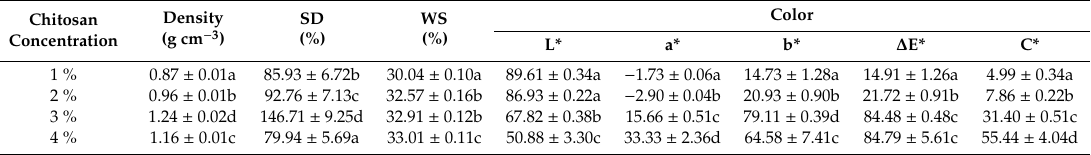
Table 2. Density, swelling degree (SD) and solubility (WS) in water and color of the chitosan films. Chitosan